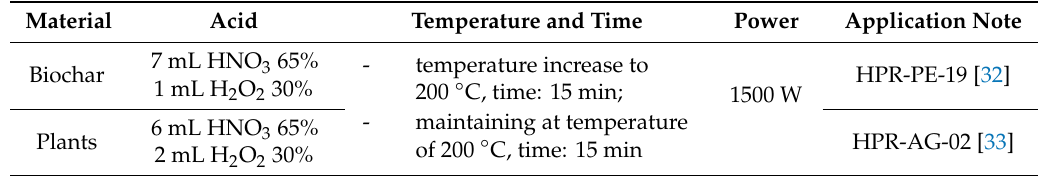
Table 4. The parameters of the mineralisation process.